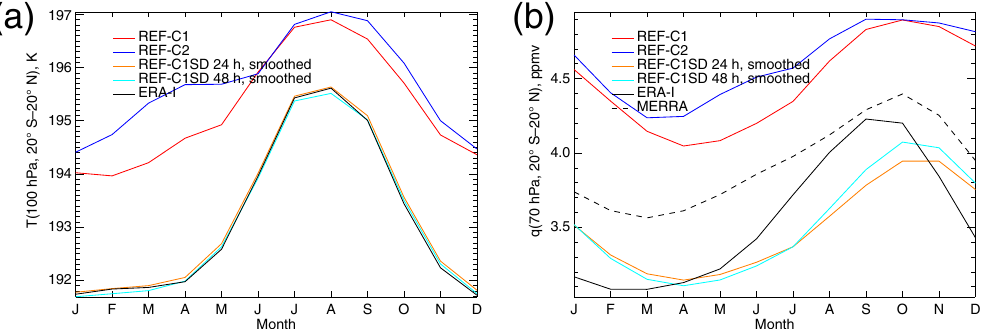
Figure 7. Tropical (20 ◦ S–20 ◦ N) seasonal cycle in (a) temperature ( T ) and (b) water vapour ( q ), averaged over the years 1980–1999, as compared to ERA-Interim reanalysis (for T ), and ERA-I and MERRA reanalyses (for q ). Tick marks indicate the middle of each